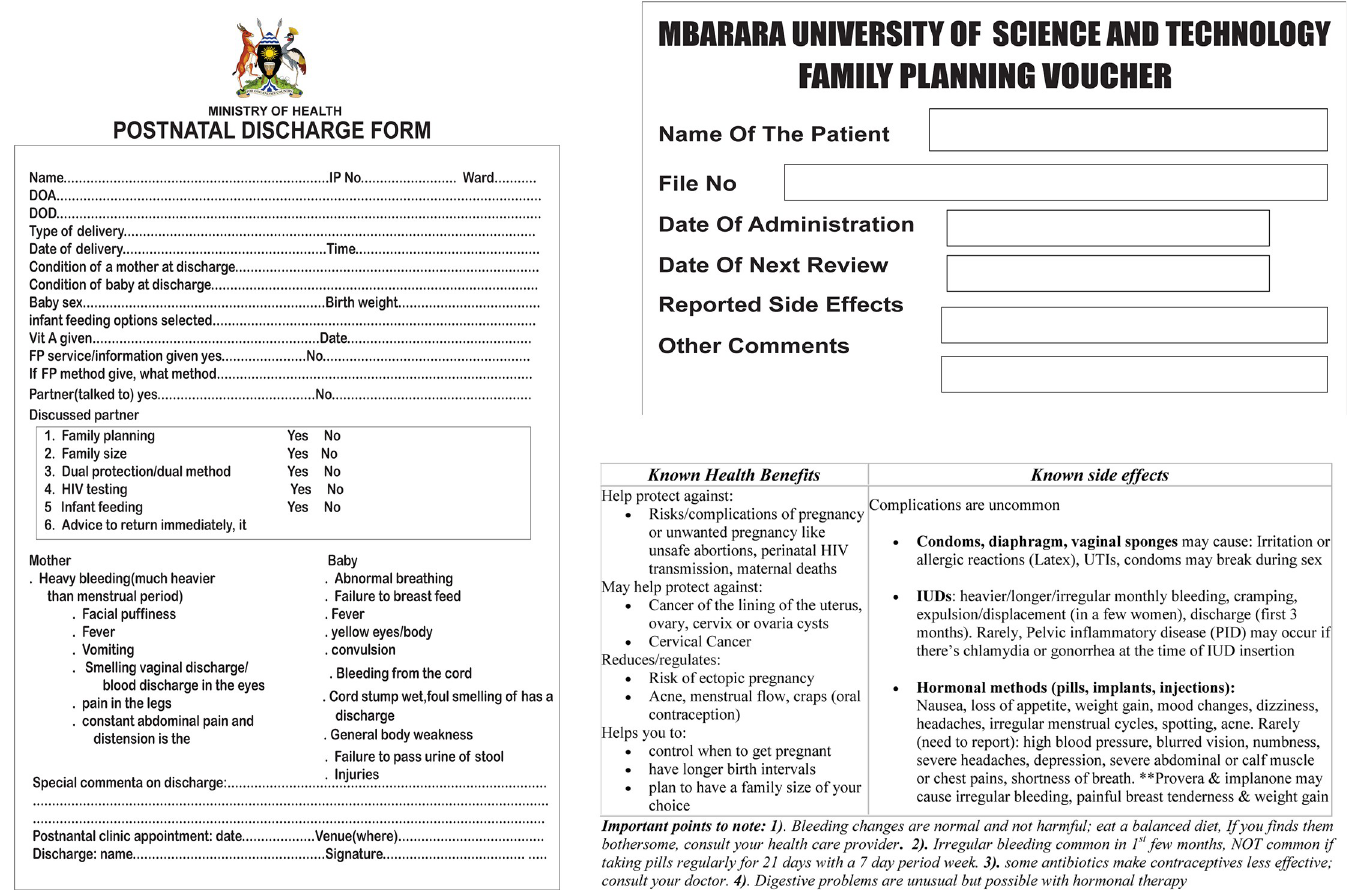
Fig 1. Ministry of health discharge form and the family planning voucher. DOA, Date of Admission; DOD, Date of Discharge; FP, family planning; IP, In-patient; IUD, intrauterine device; PID, Pelvic inflammatory disease; UTI, Urinary Tract Infection.